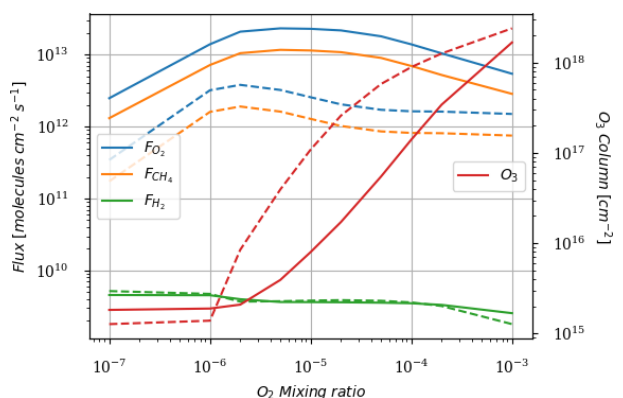
) and methane ( F CH ) fluxes, hydro- Figure 9. Surface oxygen ( F O 2 4 gen escape ( F H ), and O 3 column density as a function of surface 2 O 2 for a surface CH 4 set up at 10 − 4 . Results for a 1D model surface temperature of 280K (solid) and 220K (dashed).